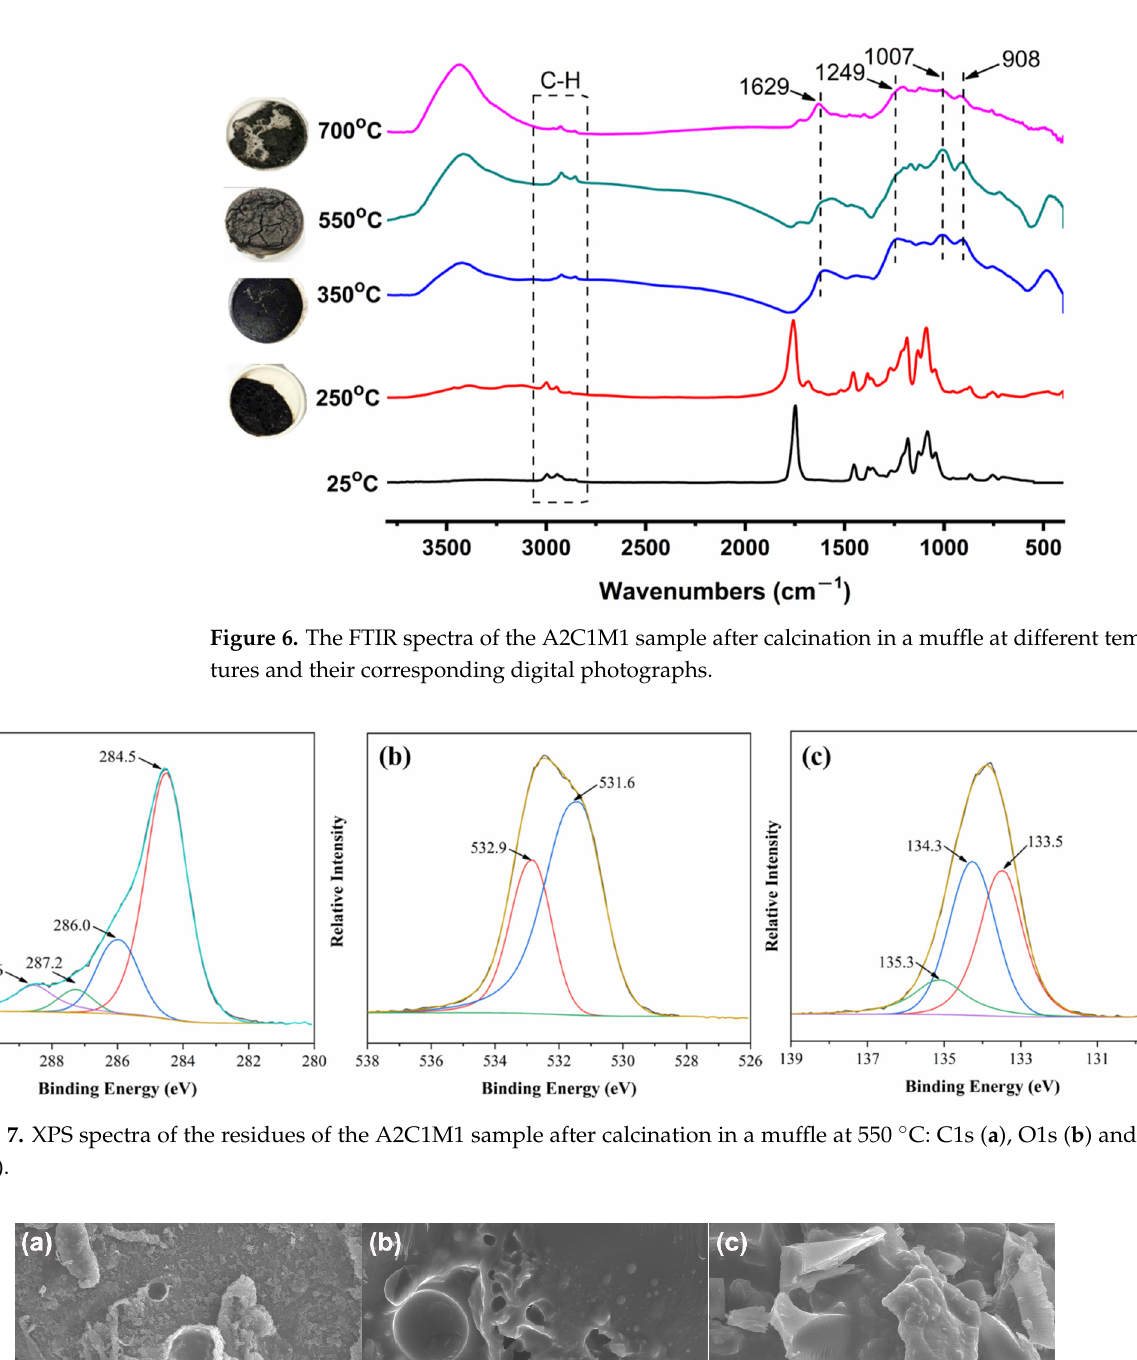
Figure 6. The FTIR spectra of the A2C1M1 sample after calcination in a muffle at different temper- atures and their corresponding digital photographs.